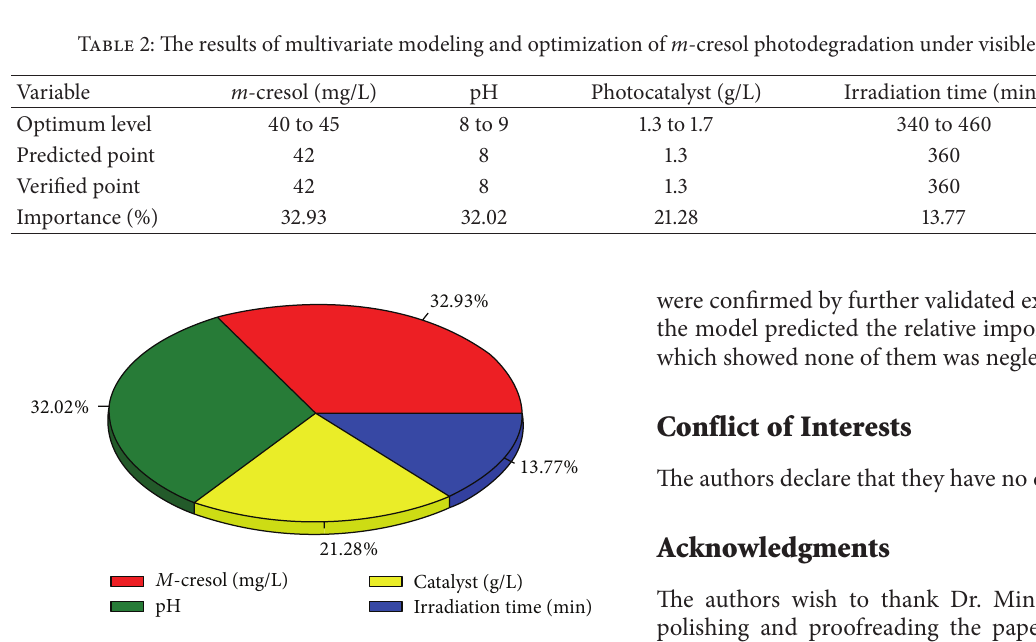
Figure 9: The relative importance of the photodegradation input variables such as irradiation time, pH amount of the photocatalyst, and m -cresol’s